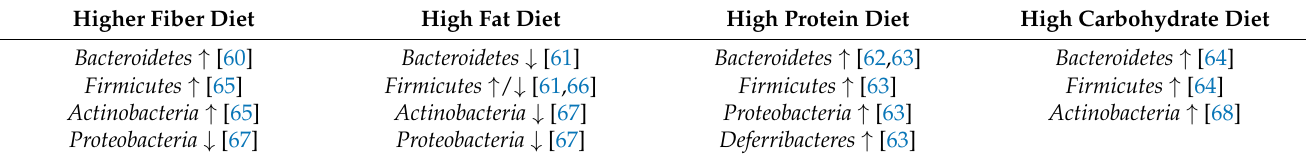
Table 2. Dietary influence in gut microbiota composition. Higher Fiber Diet